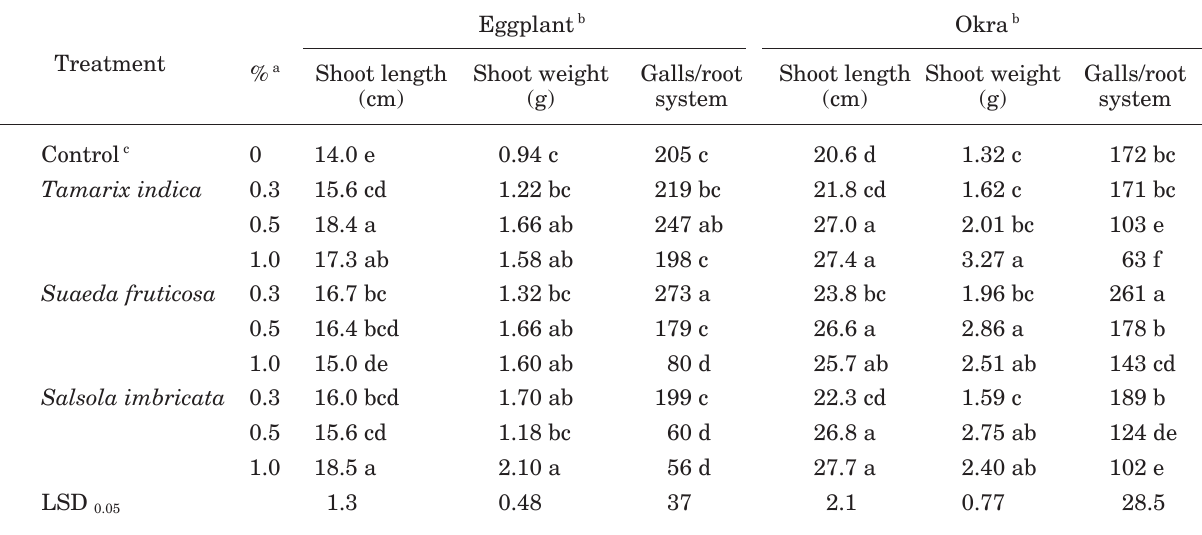
a See table 2. b Similar letters in each column are not significant according to the DMR test. c Plants inoculated with M. javanica but without